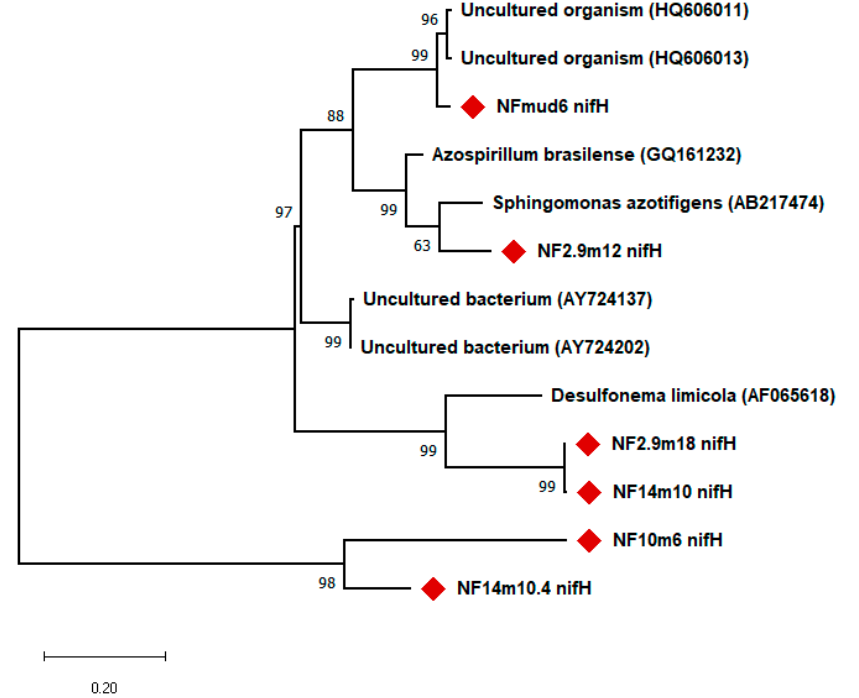
Figure 6. Phylogenetic tree showing representative nifH gene sequences among the diazotrophs. Bootstrap values greater than 50% (out of 100 replicates) are indicated at branch nodes. Bar 0.2 sub- stitutions per nucleotide position.